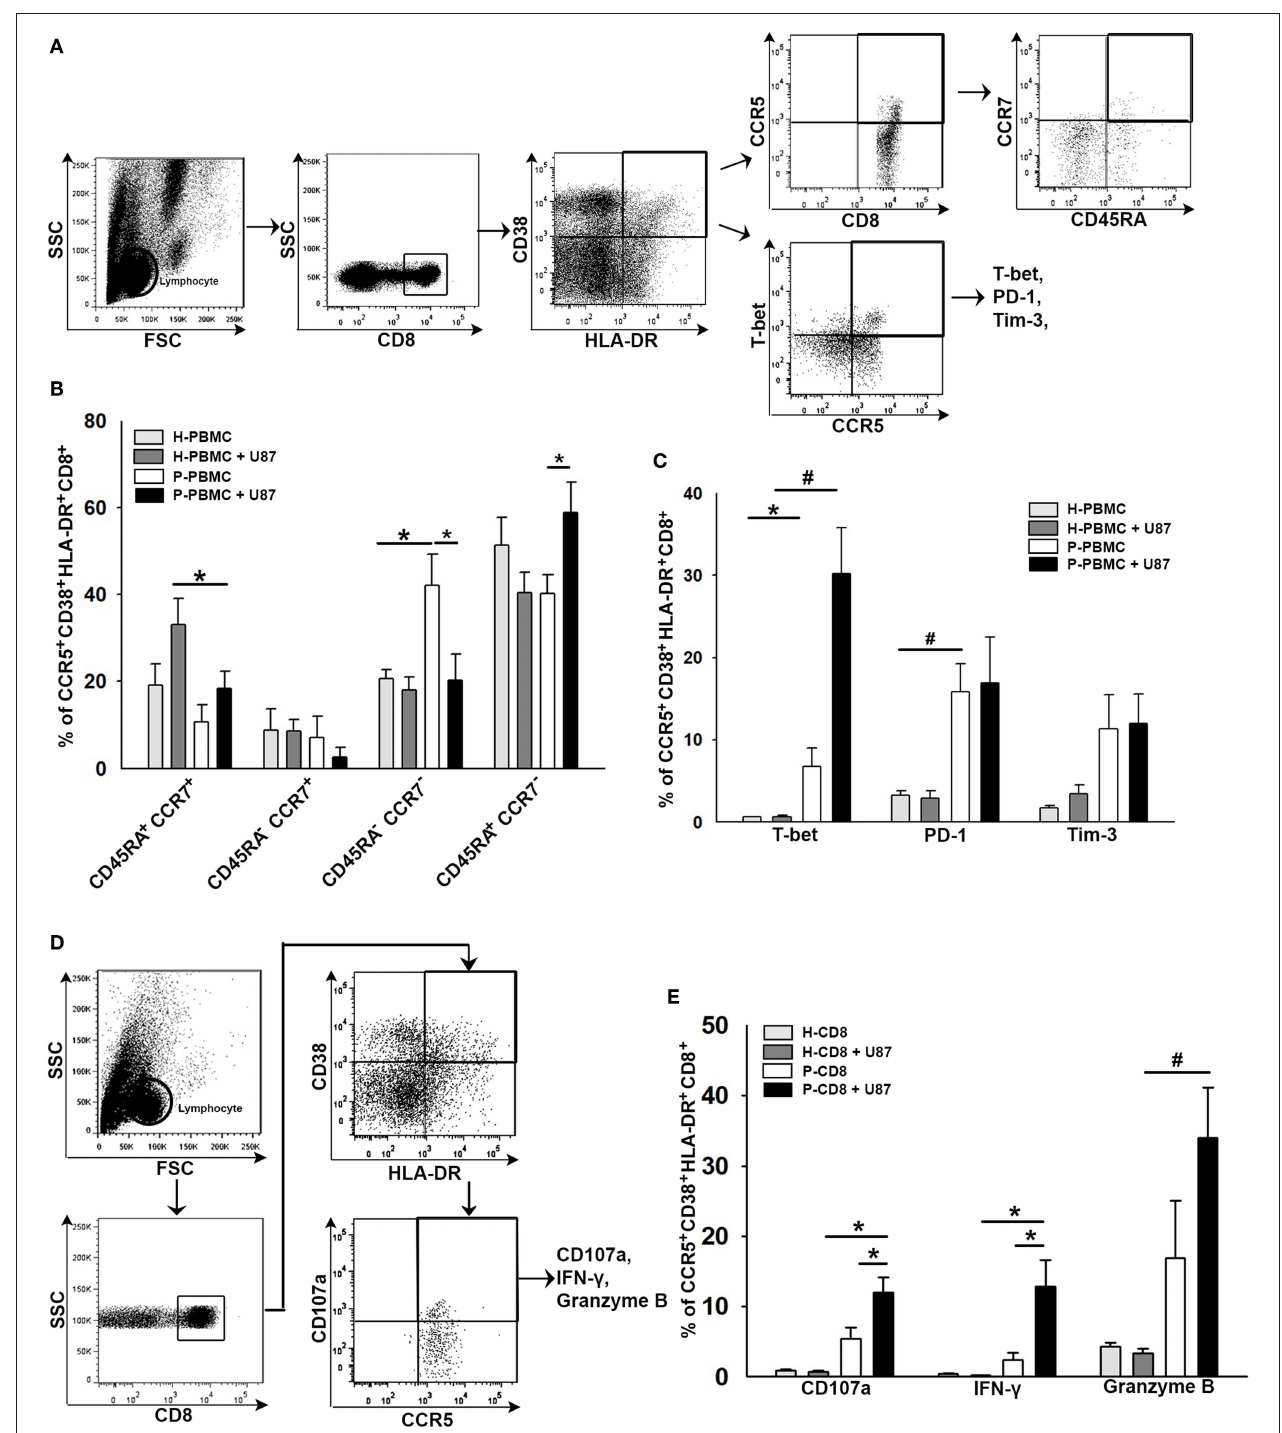
FIGURE 6 | Co-expression of functional and exhausted molecules in CCR5 + CD38 + HLA-DR + CD8 + T cells in response to glioma. (A) Representative images of gating CD45RA + CCR7 − in CCR5 + CD38 + HLA-DR + CD8 + T cells after 24h of co-culture with U87 glioma cells. (B) Responsiveness of CCR5 + CD38 + HLA-DR + CD8 + T cells as revealed by memory phenotypes in patients ( n = 11) relative to HD ( n = 6). (C) Expressions of T-bet, PD-1, and Tim-3 in CCR5 + CD38 + HLA-DR + CD8 + T cells in response to glioma ( n = 16). (D) Representative images of gating CD107a, IFN- γ , and Granzyme B in CCR5 + CD38 + HLA-DR + CD8 + T cells after 24h of co-culture with U87 glioma cells. (E) Expression of CD107a, IFN- γ , and Granzyme B in CCR5 + CD38 + HLA-DR + CD8 + T cells in response to glioma ( n = 24). Values shown are means ± SEM (bars); * p < 0.05, # p < 0.01 by Student’s t- test.